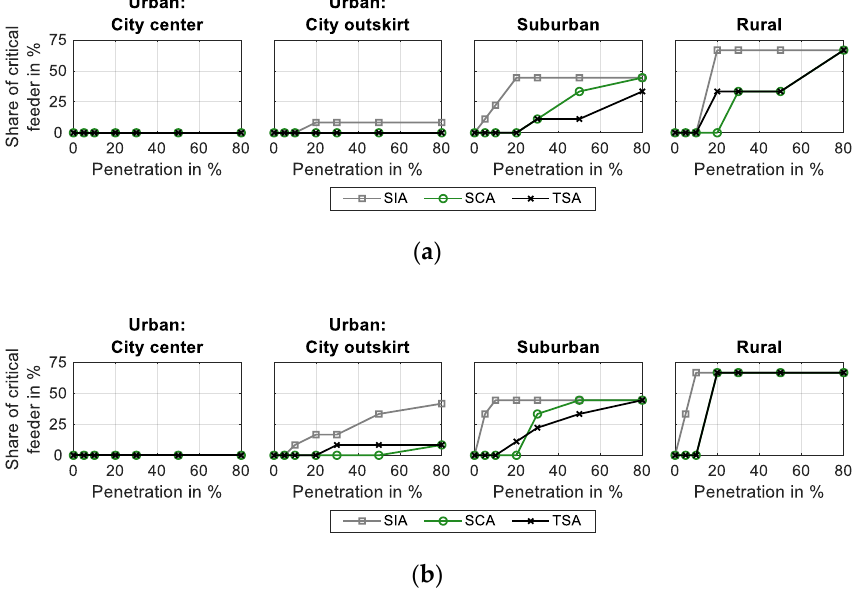
Figure 9. Share of critical feeders in terms of inadmissible voltage deviations caused by CC and EV ( a ) as well as CC, EV and HP ( b ) considering various load approaches, grid regions and penetration levels.